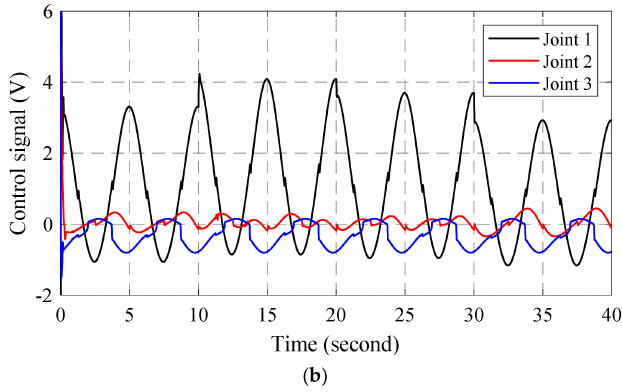
Figure 8. Control signals of ( a ) BSMC, and ( b ) ABSMC.